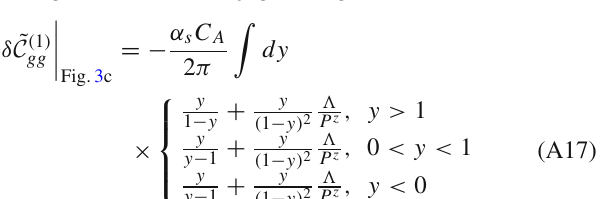
Figure 3c and its conjugate diagram